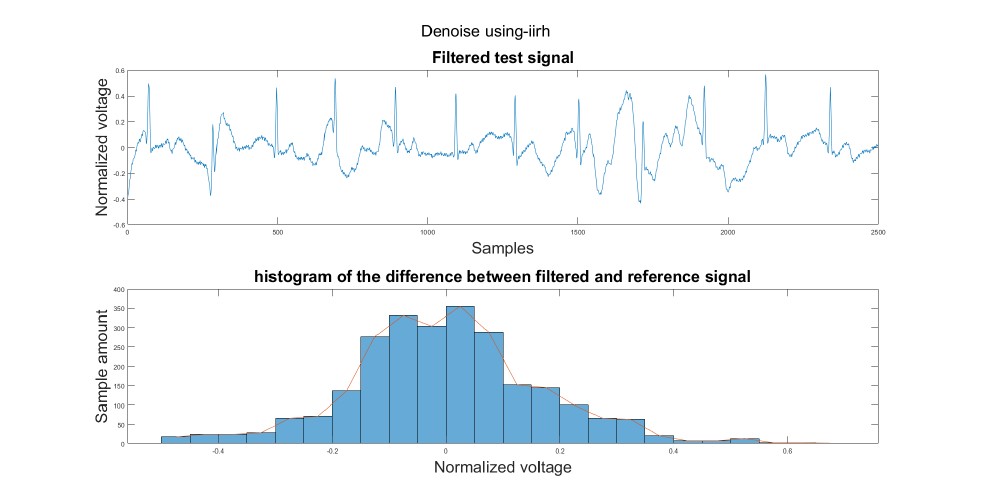
Figure A1. (1) Test signal, (2) histogram of the difference.